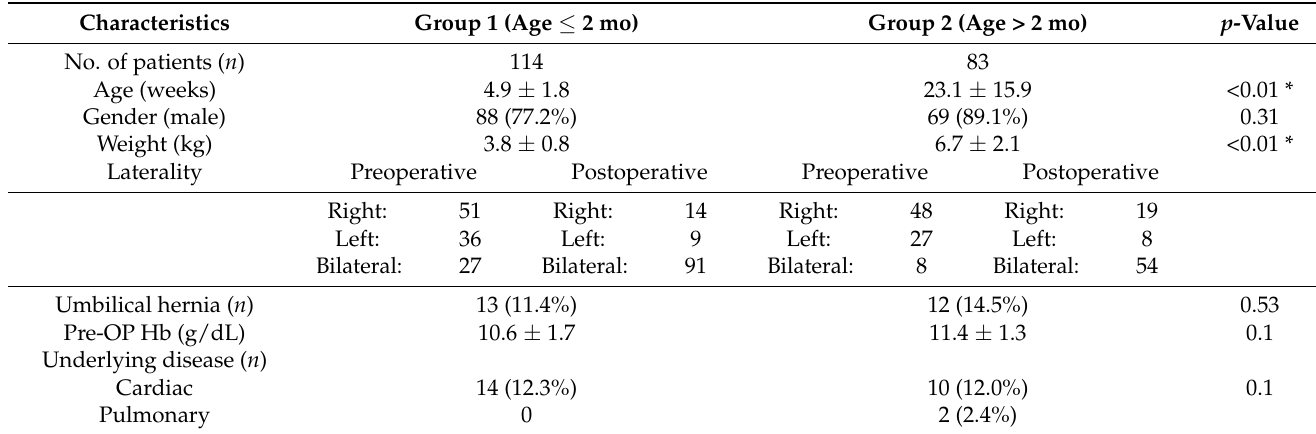
Table 1. Patient group demographics.